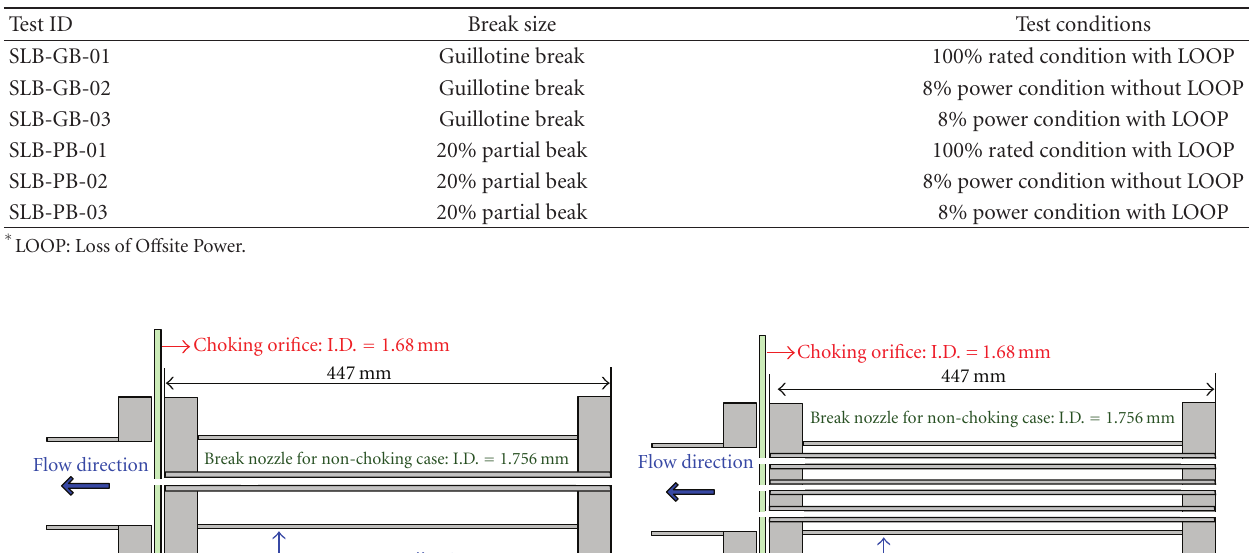
Table 7: Test matrix for SLB tests.